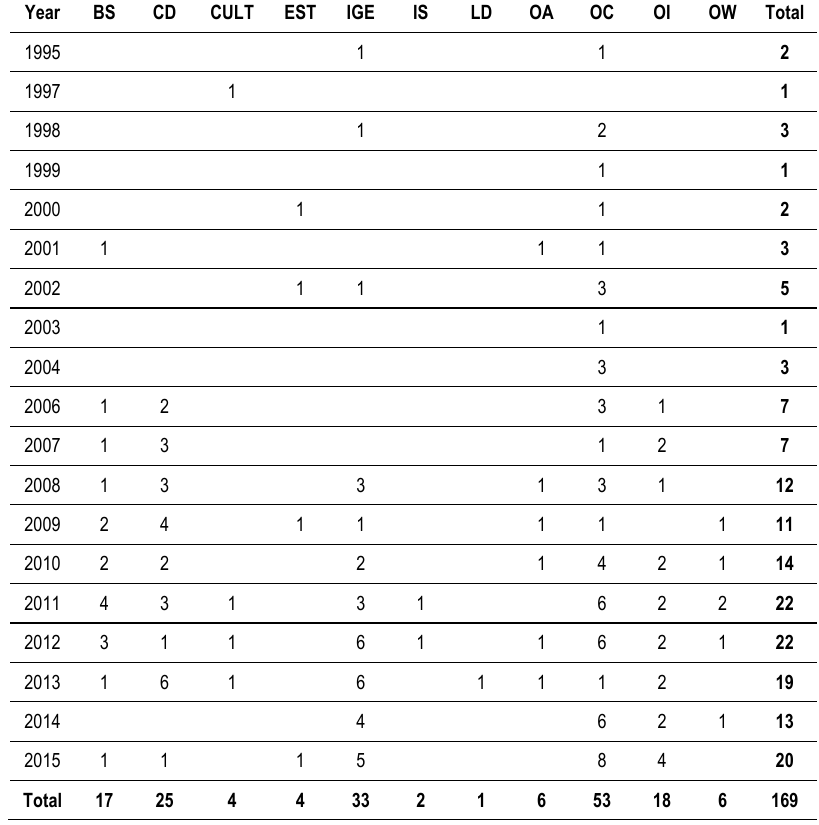
Table 3. Incidence of NCD Model´s elements addressed per year from